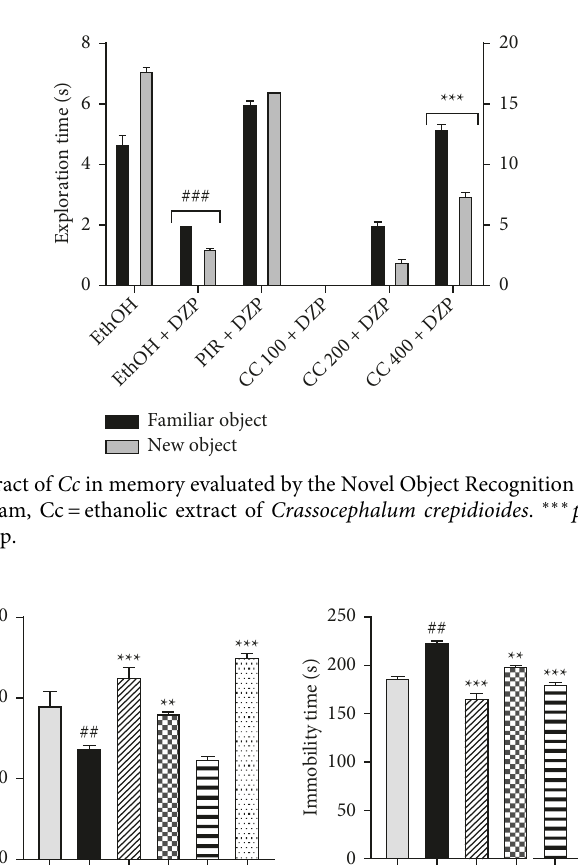
Figure 3: Effects of ethanolic extract of Crassocephalum crepidioides on mobility (a) and immobility (b) time of in mice in the tail suspension test. Bars represent the mean